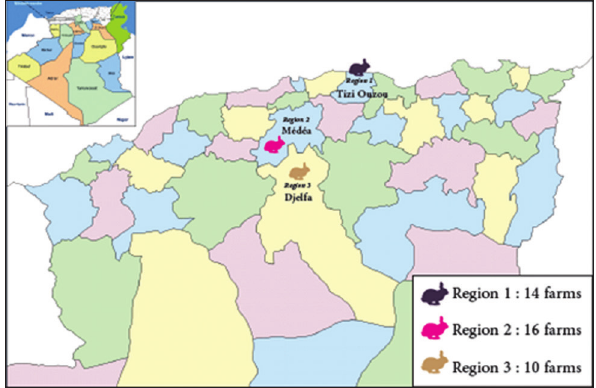
Figure-1: Map of North Algeria showing the region and geographical distribution of rabbit farms investigated in the study.